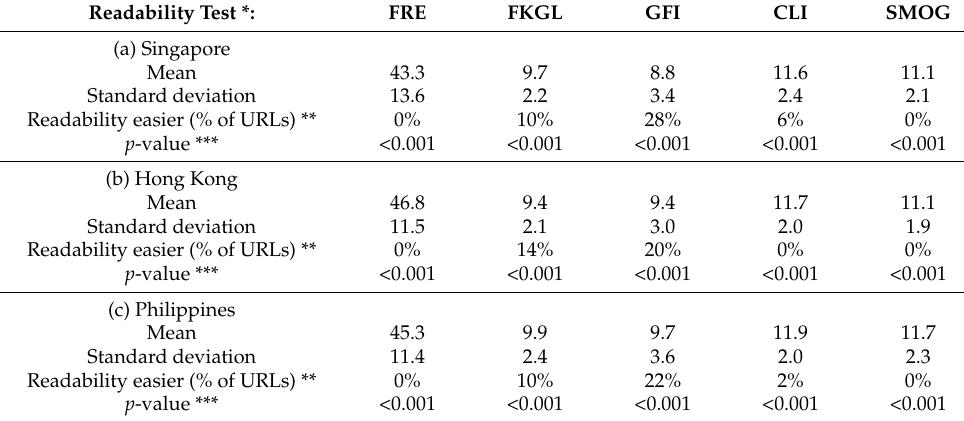
Table 1. Readability test scores by location of search.